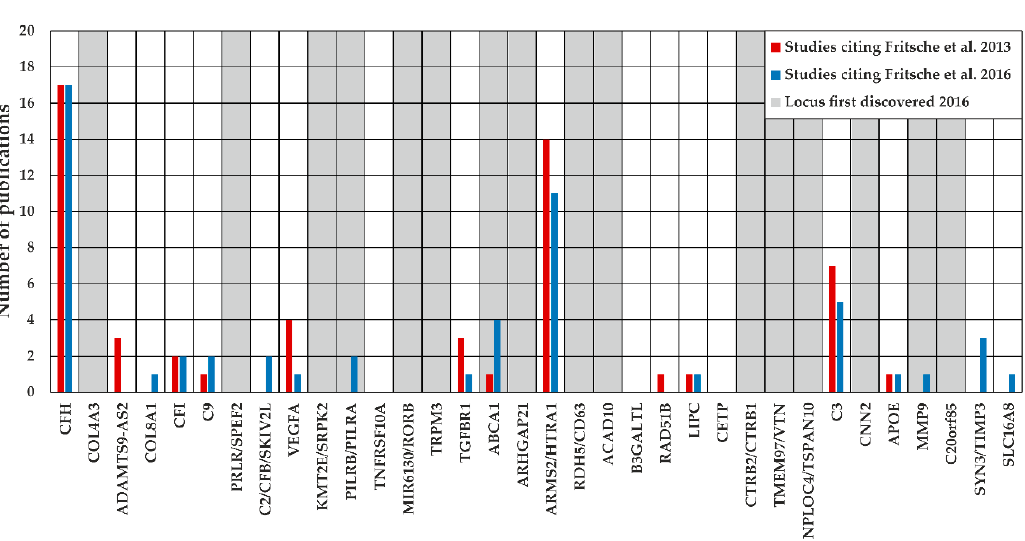
Figure 1. Categorized responses of published work citing the AMD GWAS of Fritsche et al. 2013 [20] and Fritsche et al. 2016 [8]. After quality control (see Methods), 337 publications cited Fritsche et al. (2013) (inner circle) [20] during the period 2013–2020 and 366 publications referred to Fritsche et al. (2016) (outer circle) [8] during the period 2016–2020. Articles were manually assigned to one of the five categories: “Genetic association study” (light blue), “Experimental study” (orange), “Clinical study” (grey), “Review article” (yellow), or “Referencing only” (dark blue). Articles citing both AMD GWAS [8,20] were only included in the Fritsche et al. 2016 [8] evaluation. Multi-assignment of categories was allowed for the categories “Genetic association study” and “Experimental study”. This was the case for seven studies citing Fritsche et al. 2013 [20] and four studies citing Fritsche et al. 2016 [8] (Tables S1 and